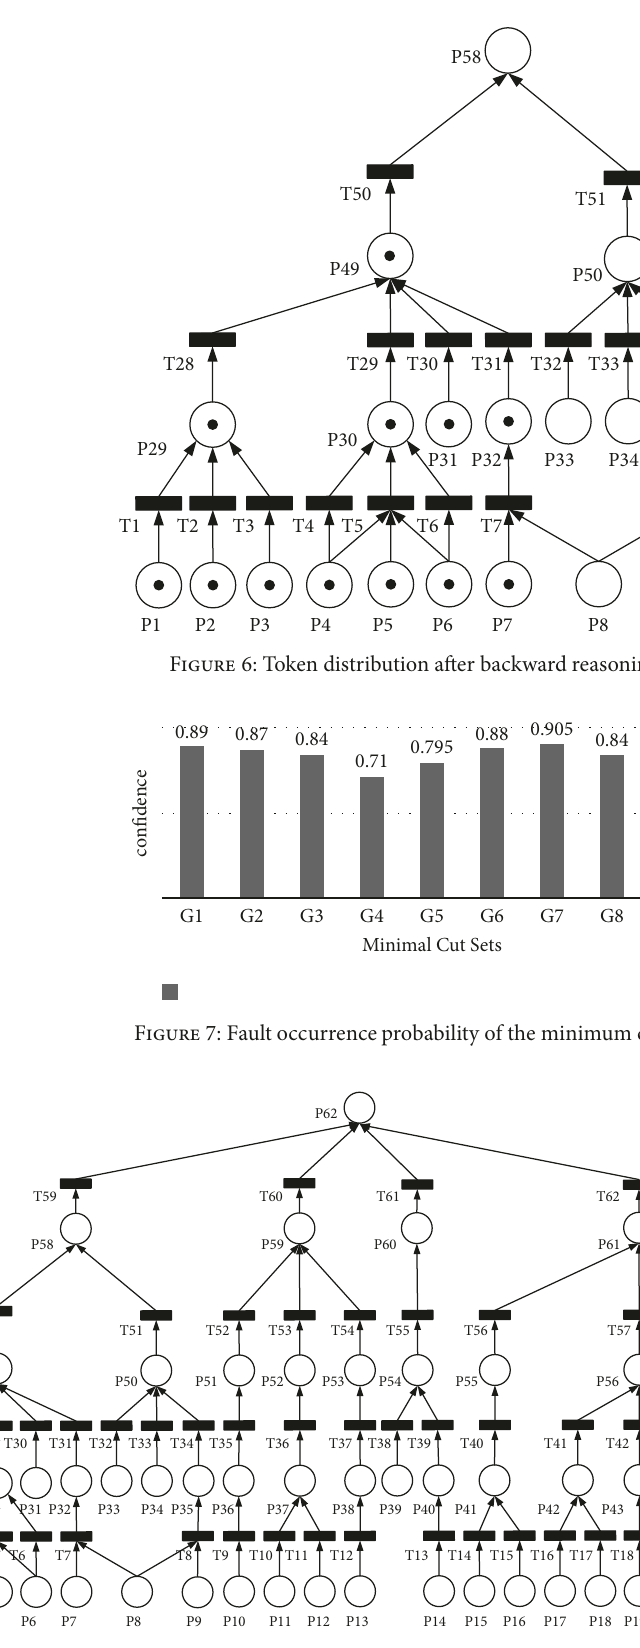
Figure 8: FFPN model diagram of the sensor fault